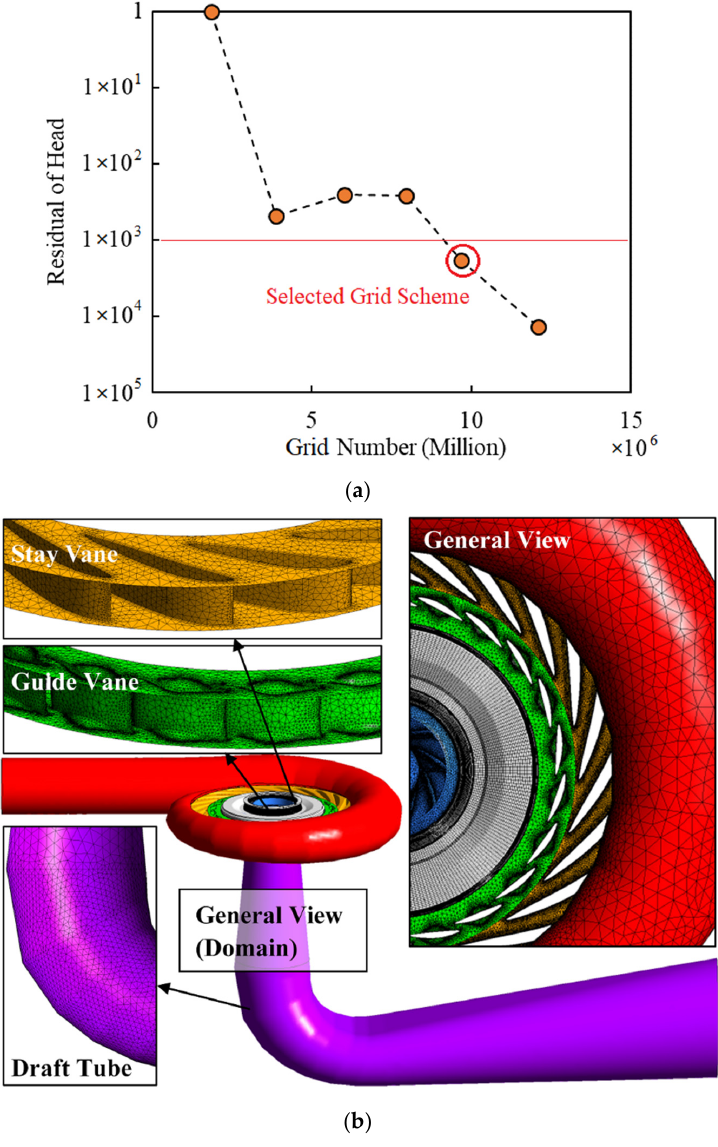
Figure 2. Fluid domain and grid. ( a ) Grid independence check; ( b ) the schematic map of the final grid.